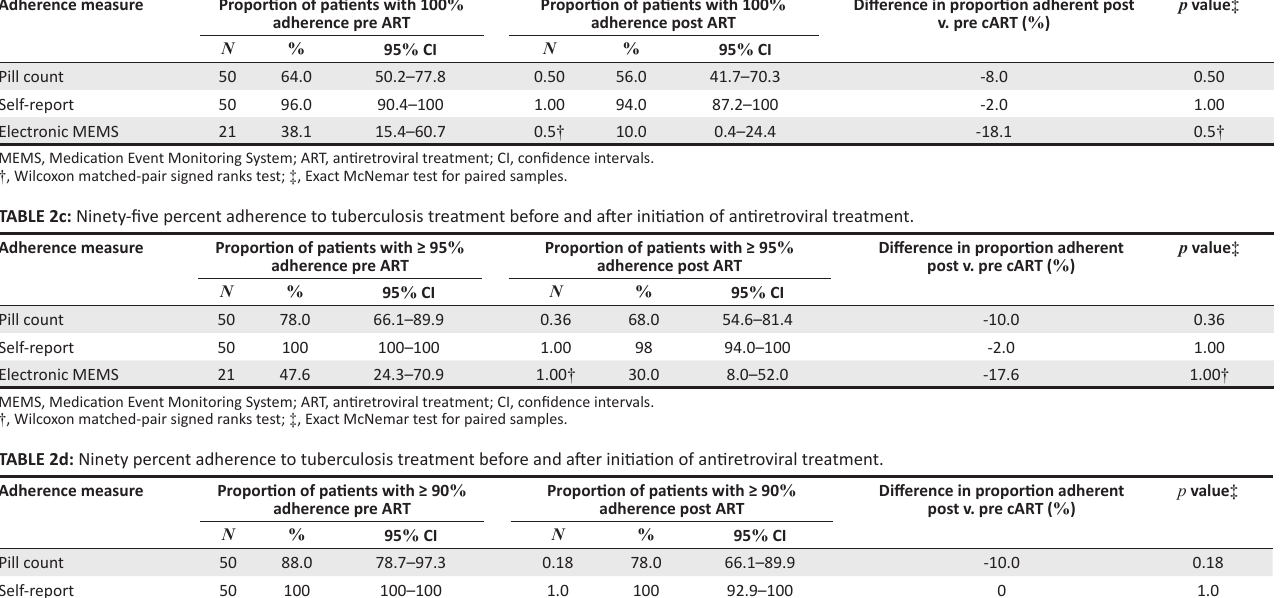
TABLE 2b: Hundred percent adherence to tuberculosis treatment before and after initiation of antiretroviral treatment. Adherence measure